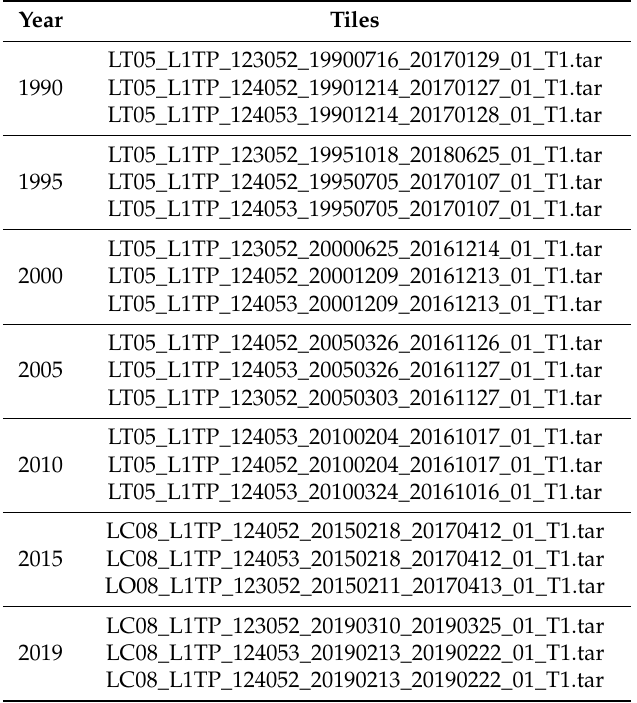
Table A1. Landsat Images used to classify land cover in Binh Thuan province (1990–2019).